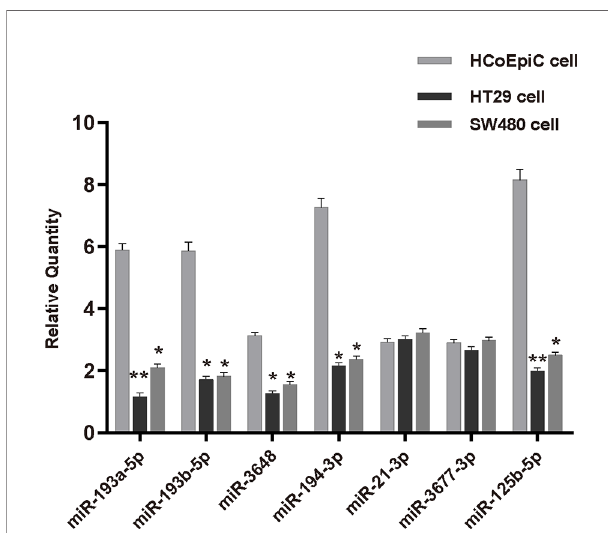
FIGURE 7 | Expression of seven miRNAs from the prognostic model in human normal colonic epithelial cells (HCoEpiC) and human colorectal adenocarcinoma cells (HT29, SW-480). *p < 0.05; **p <